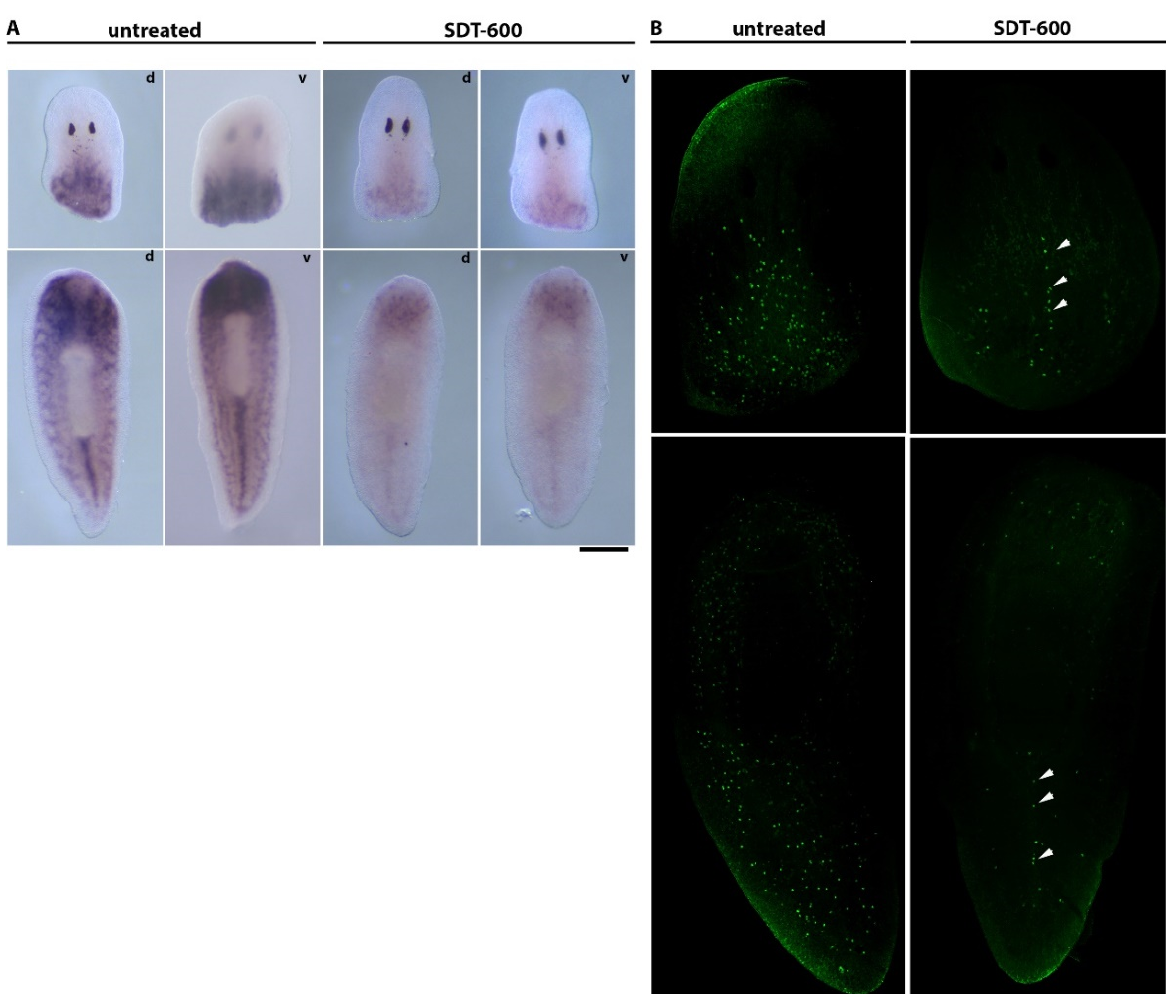
Figure 7. Analysis of DjsoxP-1 expression and mitotic activity after 5FU treatment. ( A ) Representative images in dorsal (d) and ventral (v) views of DjsoxP-1 in situ hybridization in 2-day-old regenerating control and treated animals sacrificed 15 days after 5FU treatment. ( B ) Representative images of H3p immunostaining in 2-day-old regenerating control and treated animals sacrificed 15 days after 5FU treatment. Arrows indicate mitosis in the dorsal midline cord. Scale bar corresponds to 400 μm in ( A ) and 130 μm in ( B ).